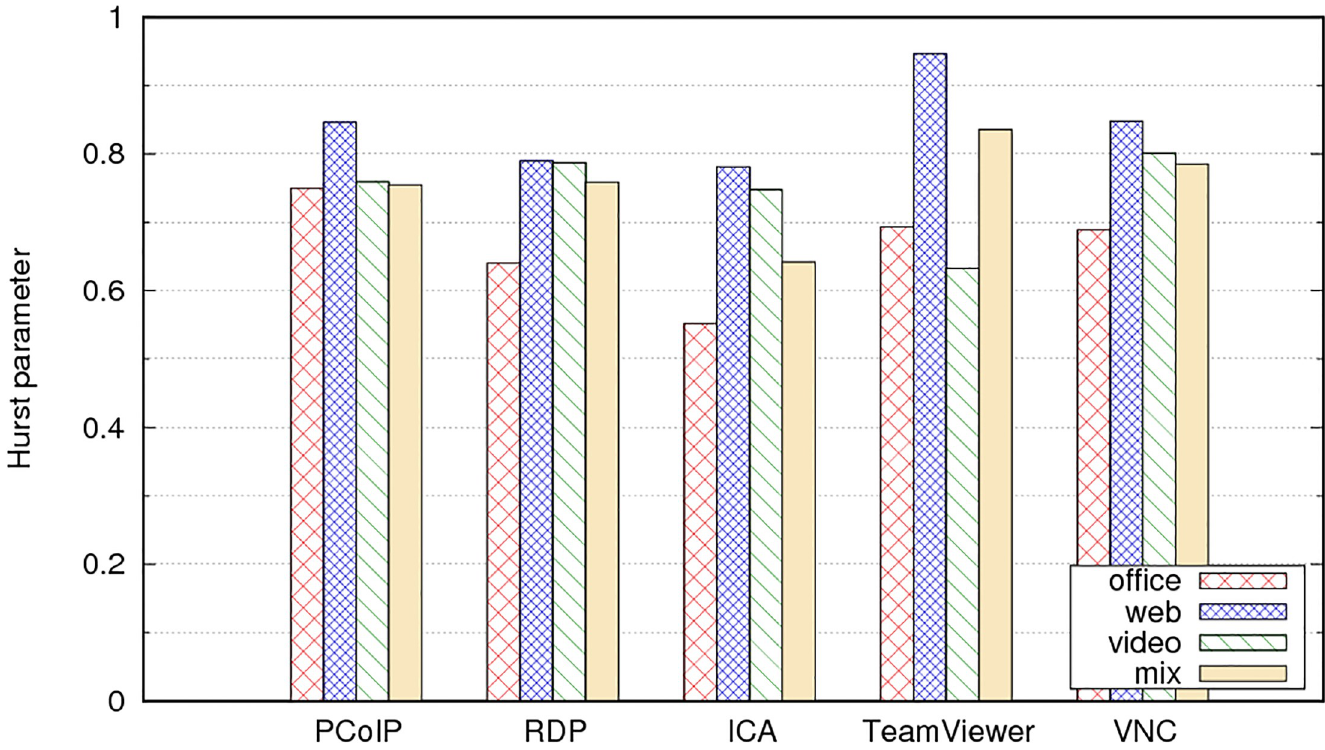
Fig 15. Comparison of values of Hurst parameter for each user profile and mixture of 30 users from each one.